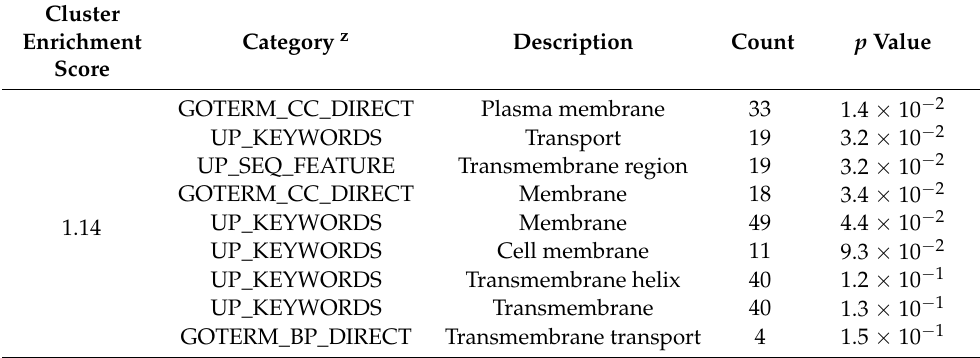
Table 3. Functional annotation clustering of genes with the exonic SNP or InDel in the T 1 and T 3 transgenic Chinese cabbage plants.